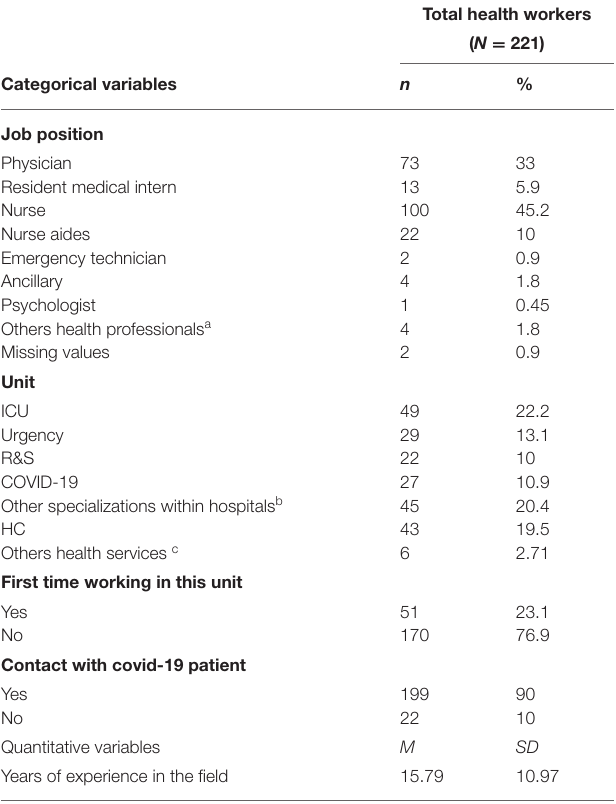
TABLE 2 | Occupational data of the total